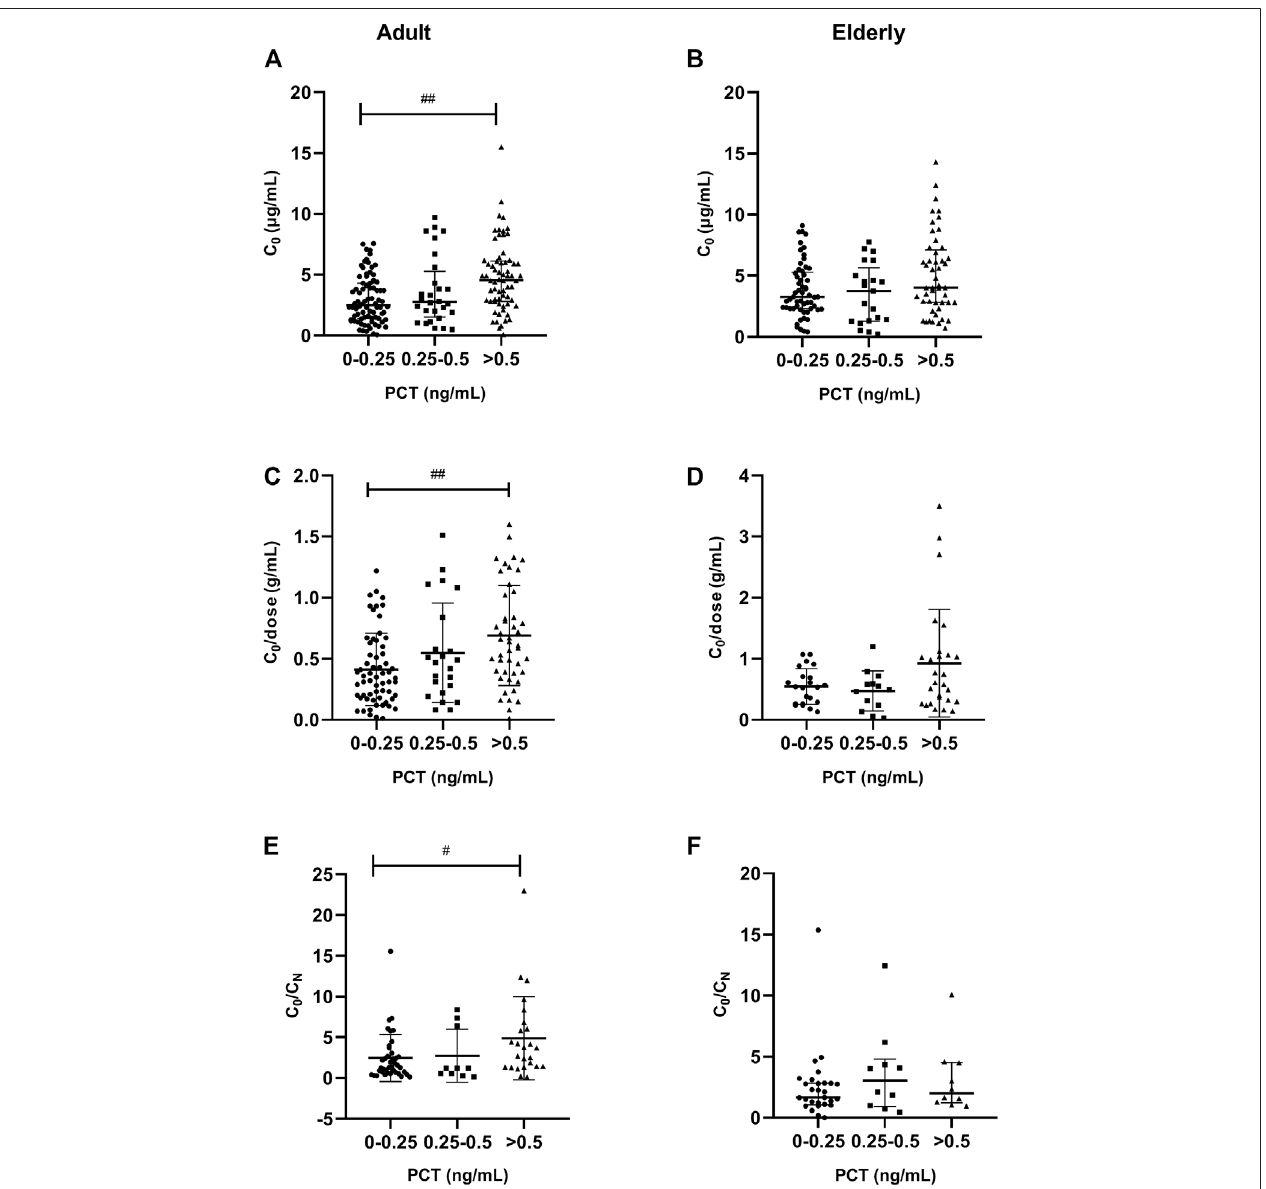
FIGURE 4 | Association of PCT plasma levels with VCZ C 0 , C 0 /dose ratio and VCZ C 0 /C N in adult and elderly patients. (A,B) Distribution of VCZ C 0 . (C,D) Distribution of VCZ C 0 /dose ratio. (E,F) Distribution of VCZ C 0 /C N ratio. # p < 0.05, ## p < 0.01.